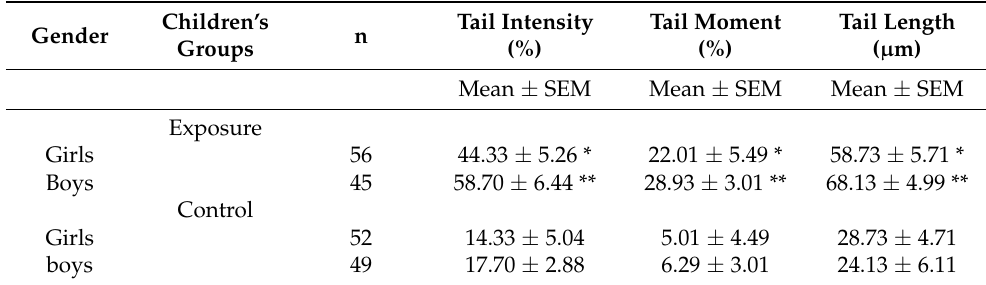
Table 3. Mean of the genotoxic parameters by gender in buccal mucosa cells in the (El Fraile, Taxco de Alarc ó n)-exposure and (Chilpancingo)-control groups in Guerrero State, Mexico.